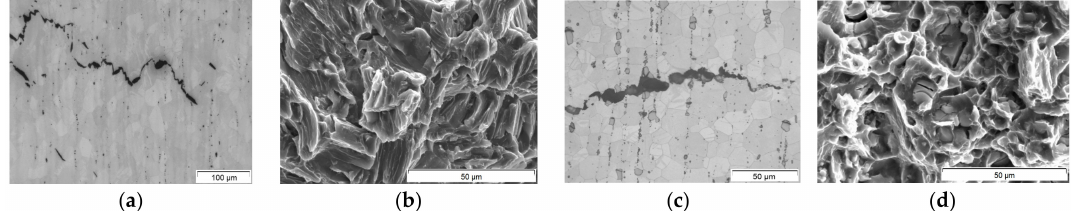
Figure 7. Micrographs at the crack tip ( a , c ) and SEM images of the fracture surface ( b , d ) of crack propagation under bending in ( a , b ) extruded Mg10Gd and ( c , d ) extruded